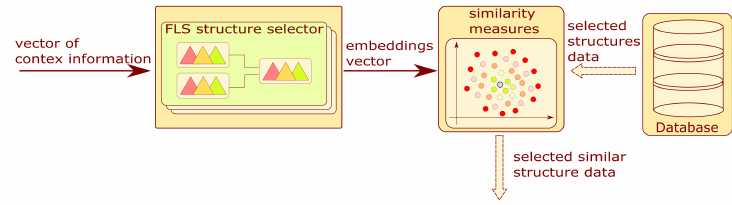
Figure 4. Block diagram of structure selector